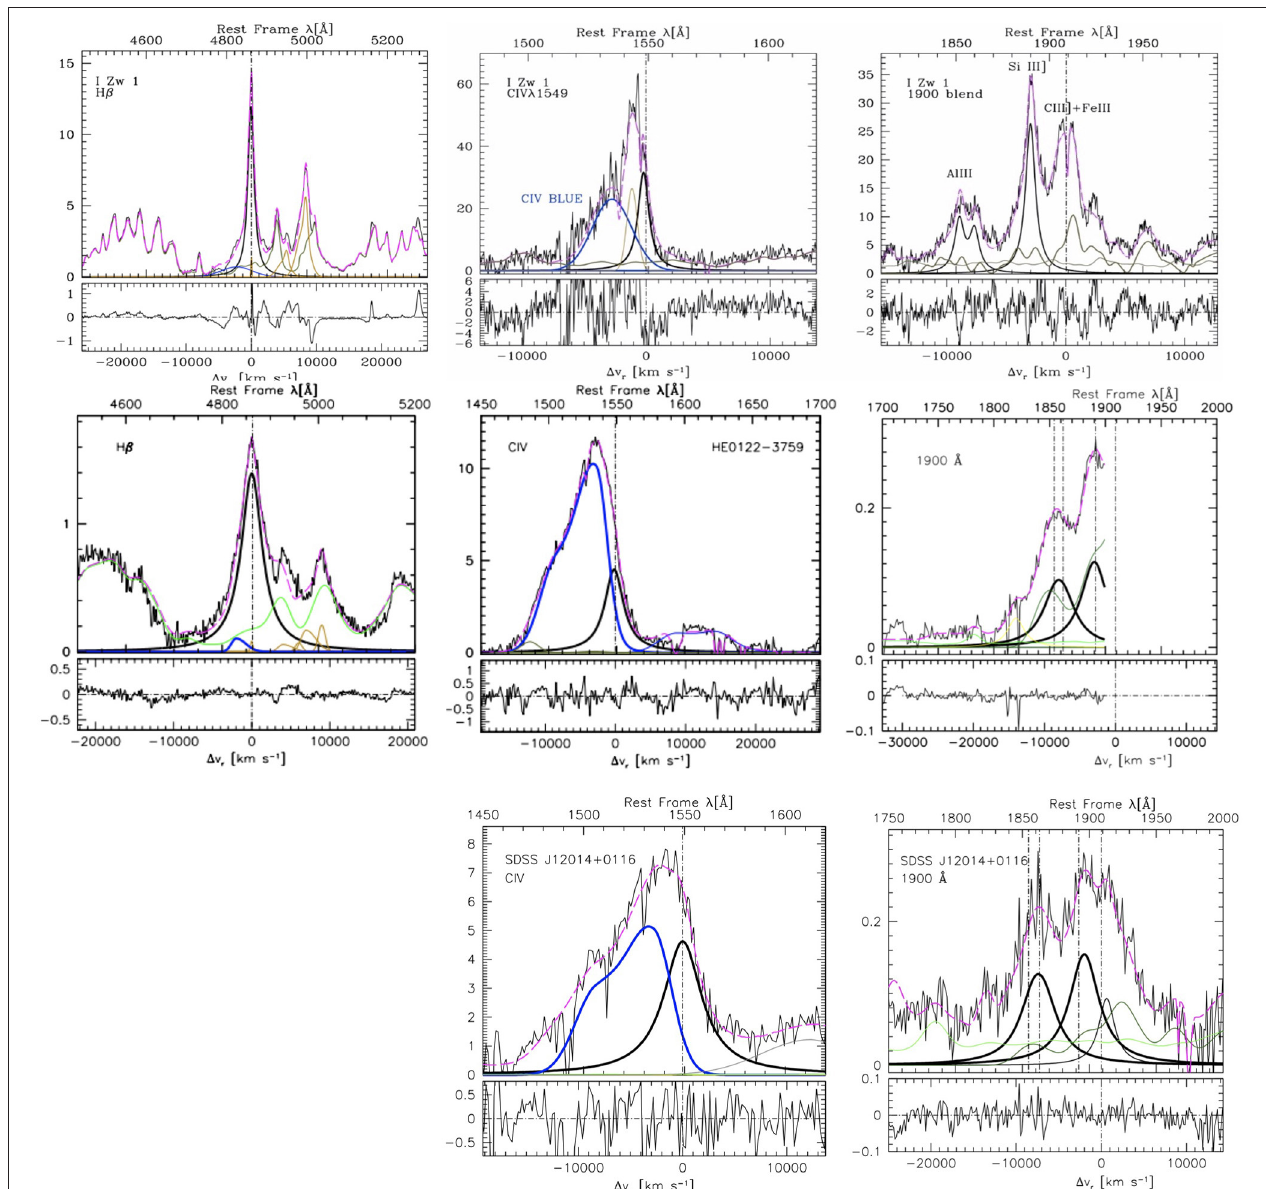
FIGURE 1 | Intercomparison of line profiles of H β (left), C IV λ 1549 (middle), and Al III λ 1860 in the 1900 blend for three xA quasars of widely different luminosity [top: I Zw 1 (Marziani et al., 2010); middle: HE0122-3759 (Sulentic et al., 2017); bottom: SDSS J12014-0116 (Negrete et al., 2012)]. The thin black line shows the continuum subtracted spectra, the thick black lines trace the virialized symmetric broad component, and the thick blue line the blueshifted excess. Fe II emission is shown in lemon green, and narrow lines in orange color, He II λ 1640 in gray, and Fe III in dark green. The magenta dot-dashed line traces the model of the spectrum including all emission components. Note the absence or weakness of the BLUE for both H β and Al III λ